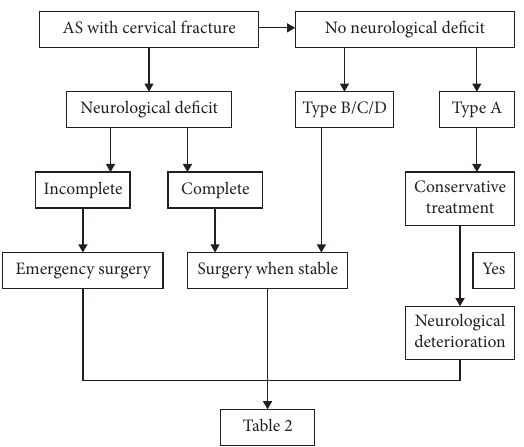
Figure 2: Treatment basis diagram.